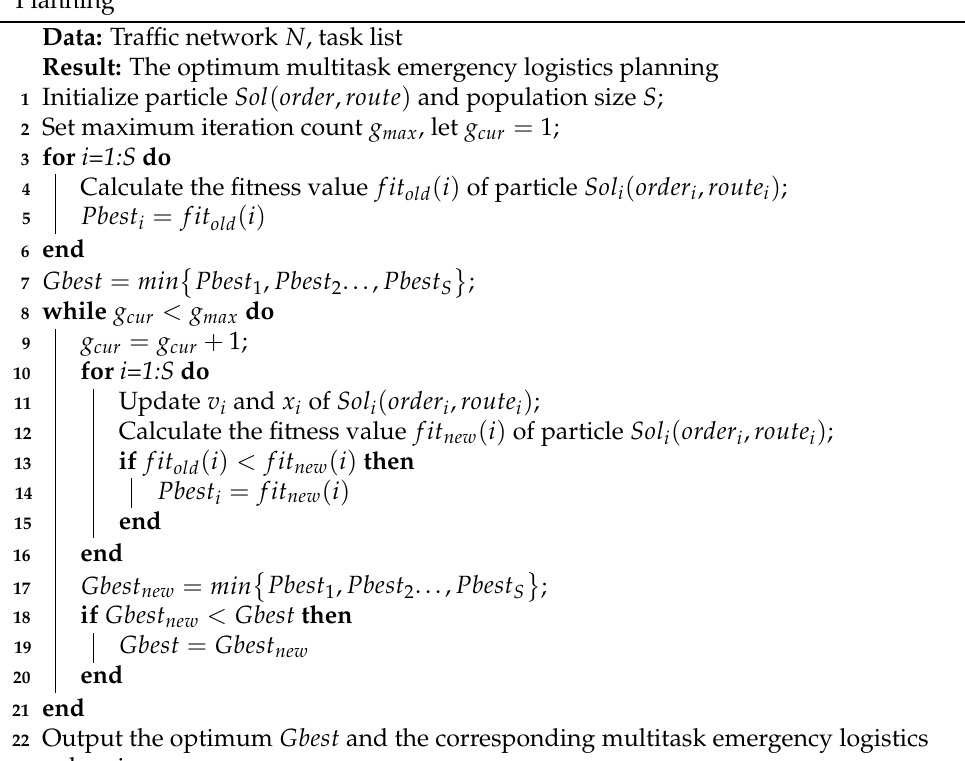
Algorithm 3: General Optimization Algorithm of Multitask Emergency Logistics